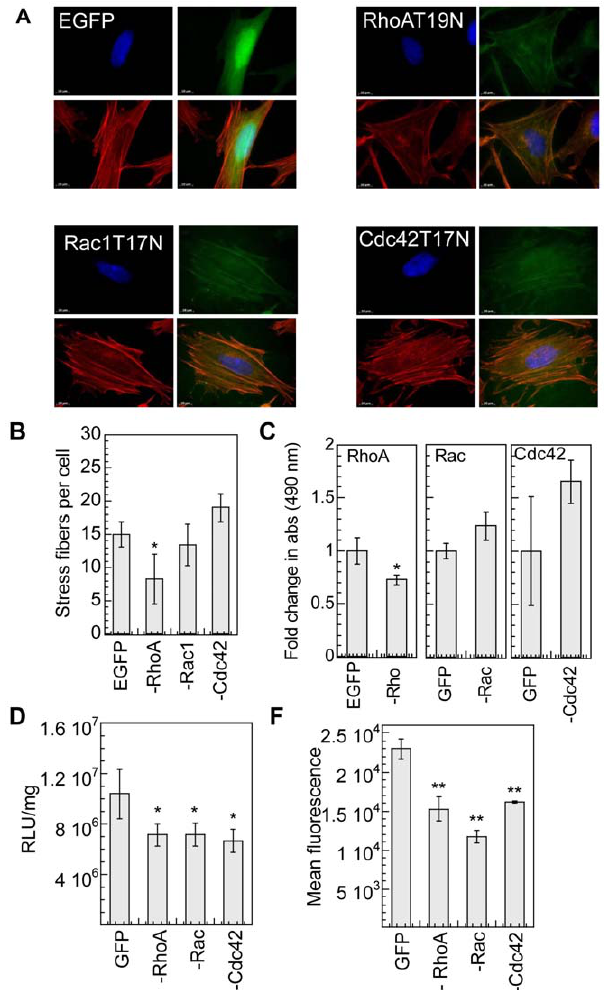
Figure 3. RhoGTPase inhibition using dominat negative gene products decreases transgene expression. mMSCs were transient- ly transfected with dominant negative forms of RhoA, Rac1 or Cdc42 with a plasmid also containing EGFP. 24 hours post transfection, cells were replated on fibronectin coated plates and cultured for 16 hours prior to bolus transfection. Cells transfected with pEGFP were used as control. ( A ) Alexa488 conjugated phalloidin (green), and Hoechst dye (blue) staining. Images were taken with a Zeiss AxioObserver Z1 inverted microscope at 100 6 magnification. ( B ) Stress fiber quantifica- tion. Statistical analysis was done using a one-way Anova followed by